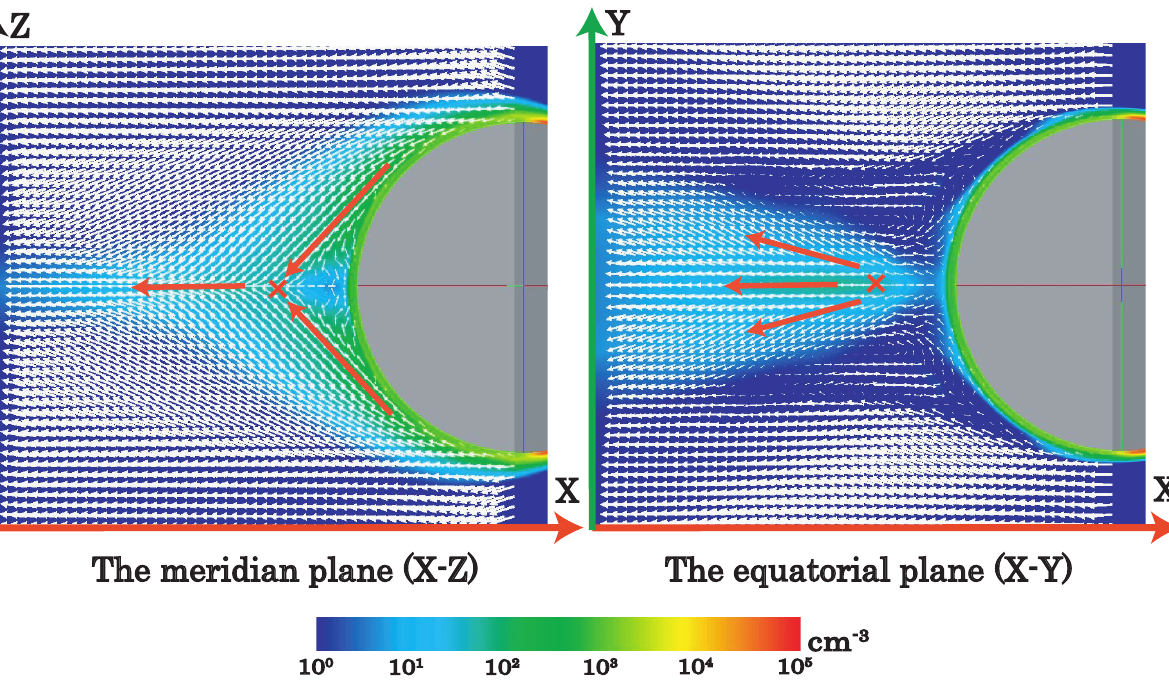
Fig. 6. The distribution of O + density (color) superposed by the velocity vectors (white arrows). The solar wind flows from the right. The 2 left panel represents the meridian plane, while the right panel represents the equatorial plane.